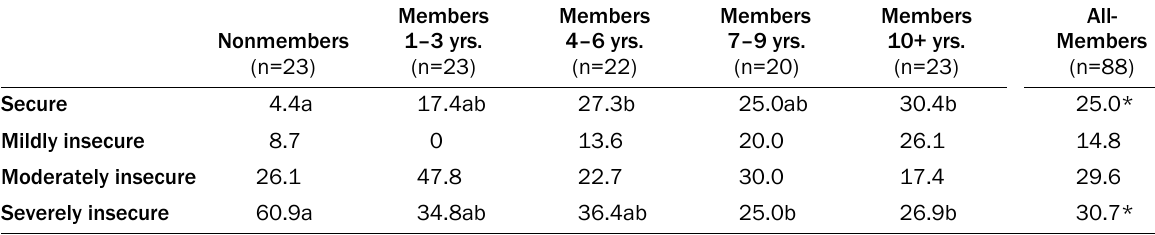
Table 7. Degree of Household Food Insecurity by Dairy Group Membership Duration (% of households) 1